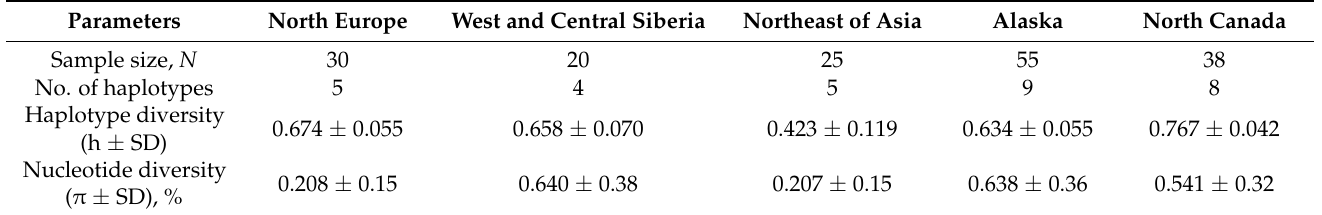
Table 2. Genetic diversity indices of Pterostichus brevicornis brevicornis samples based on COI sequences. Parameters North Europe West and Central Siberia Northeast of Asia Alaska North Canada Sample size, N 30 20 25 55 38 No. of haplotypes